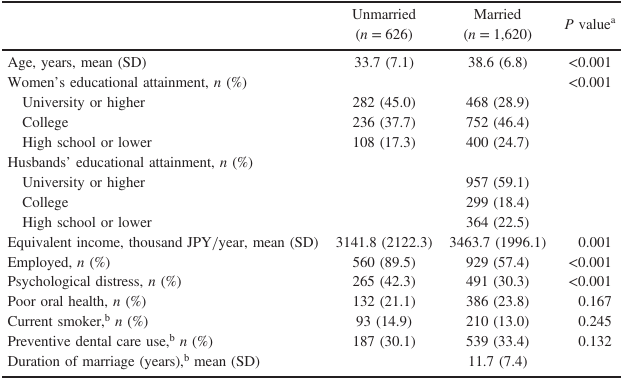
Table 1. Characteristics of unmarried women and married women Unmarried ( n =626)